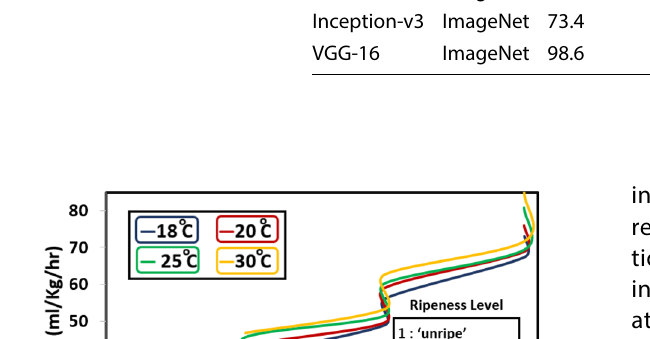
Table 2 Fine-grained classification performance on different networks